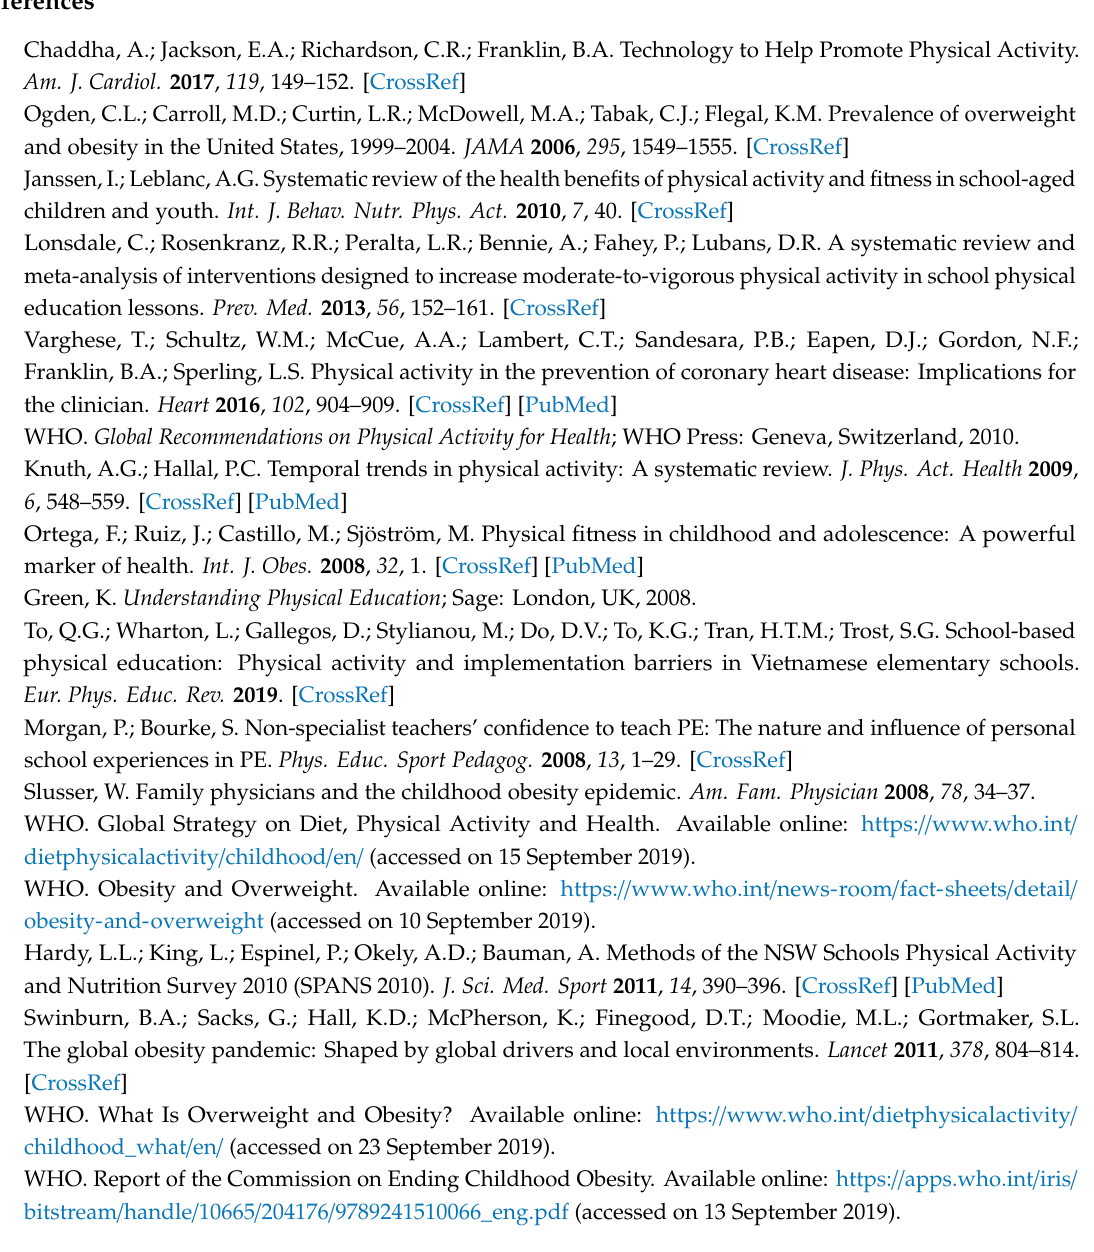
Table S1: Quality assessment of 19 studies, File S2: Examples of Search